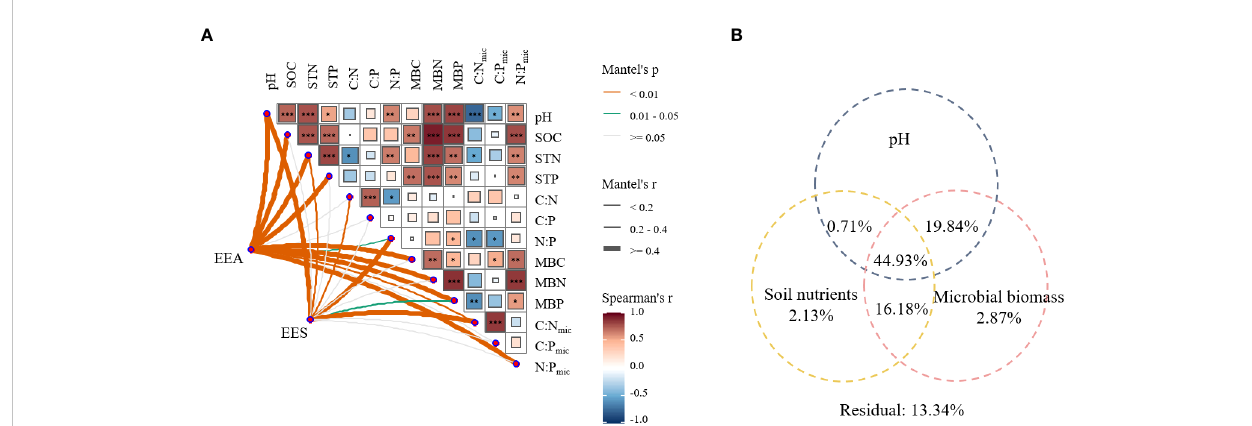
FIGURE 5 Relationship between pH, soil nutrient, microbial biomass, and soil enzyme characteristics (A) , and variation partitioning analysis (VPA) of pH, soil nutrients, and microbial biomass for EEA and EES (B) . SOC, soil organic carbon; STN, soil total nitrogen; STP, soil total phosphorus; C:N, ratio of SOC to STN; C:P, ratio of SOC to STP; N:P, ratio of STN to STP; MBC, microbial carbon biomass; MBN, microbial biomass nitrogen; MBP, microbial phosphorus biomass; C:N mic , ratio of MBC to MBN; C:P mic , ratio of MBC to MBP; N:P mic , ratio of MBN to MBP. C EEA , the sum of BG, CBH, and BX; N EEA , the sum of NAG and LAP; P EEA , AP activity. Explanation rates < 0 is not shown. * P < 0.05; ** P < 0.01; *** P <